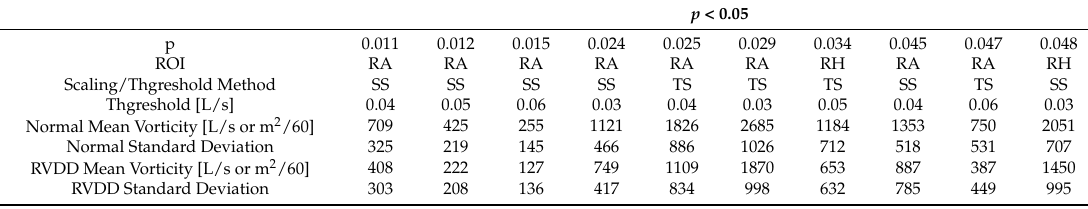
Table 2. Results for spatially integrated peak early diastolic vorticity in three regions of interest for several scaling methods. SS = integrated vorticity scaled by cardiac index, TS = vorticity thresholded by cardiac index. Only results showing a p -value of less than 0.05 are shown. P -values increase from left to right.